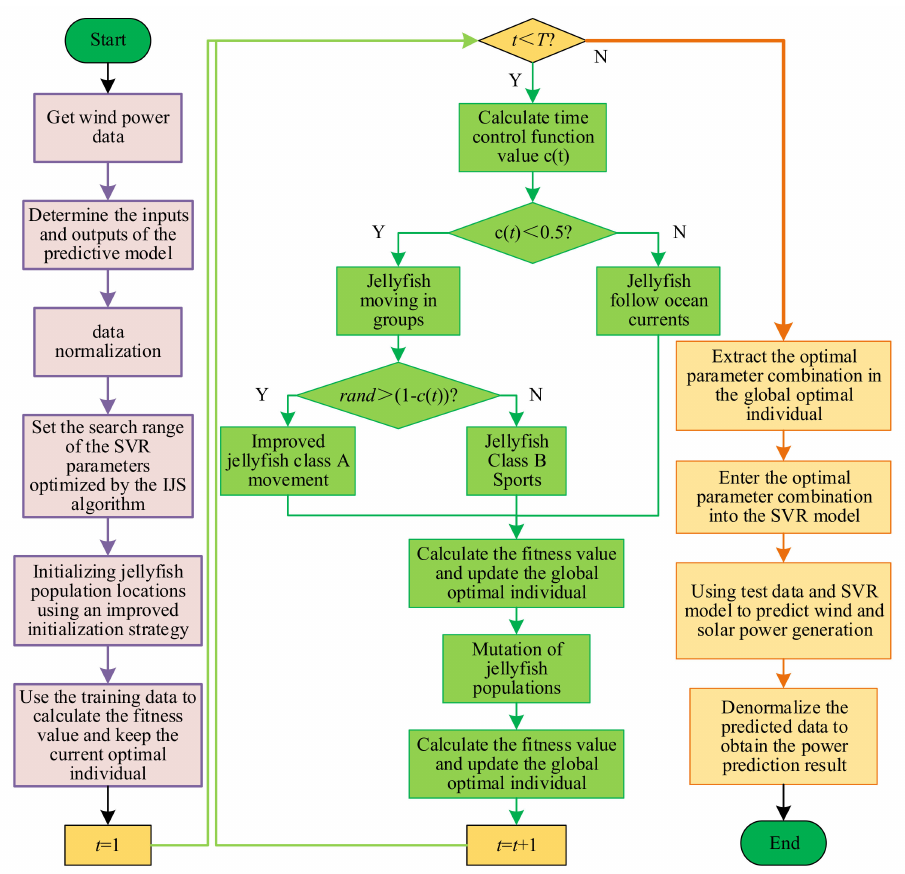
Figure 3. Wind power prediction based on the IJS-SVR